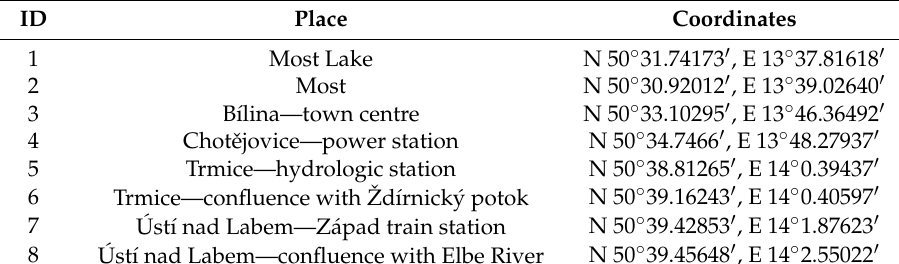
Table 2. Sampling points with their coordinates.